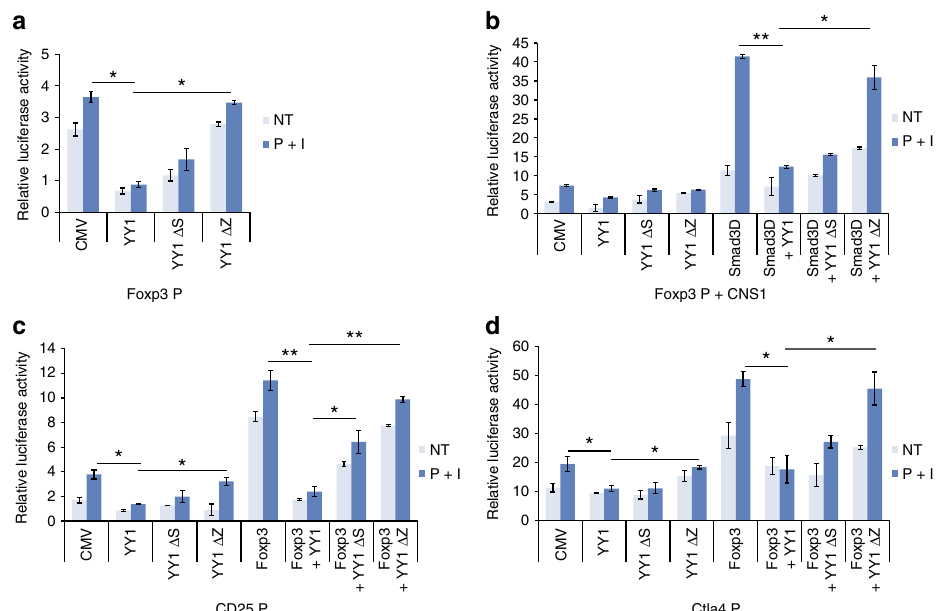
Figure 10 | Spacer and Zinc finger domains of YY1 are essential for inhibiting transactivation activity of Smad3 or Foxp3. Transactivation activity of Smad3, Foxp3 or YY1 domain mutants at the promoters of the Foxp3 , CD25 or Ctla4 genes was measured by transient reporter assay. EL4 cells were transfected with Foxp3 promoter-luc ( a ), Foxp3 promoter-CNS1-luc ( b ), CD25 promoter-luc ( c ) or Ctla4 promoter-luc ( d ) reporter construct in combination with Smad3D -, Foxp3 - or YY1 domain mutant expression vectors. Error bars shown in a – d represent s.d. Statistical differences were analysed